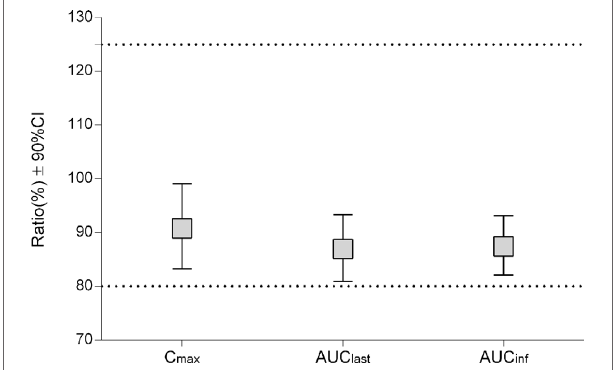
FIGURE 3 | Pharmacokinetic equivalence between ANX and Navelbine.